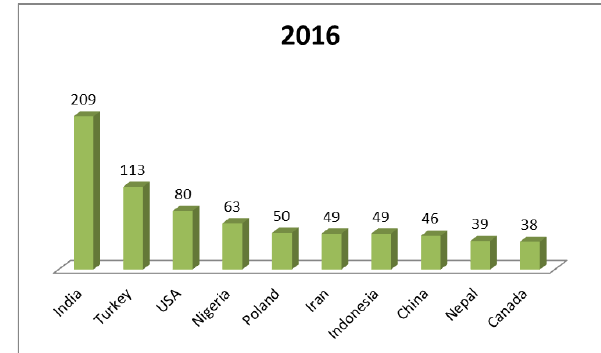
Figure 7. Top ten countries with the highest number of members in